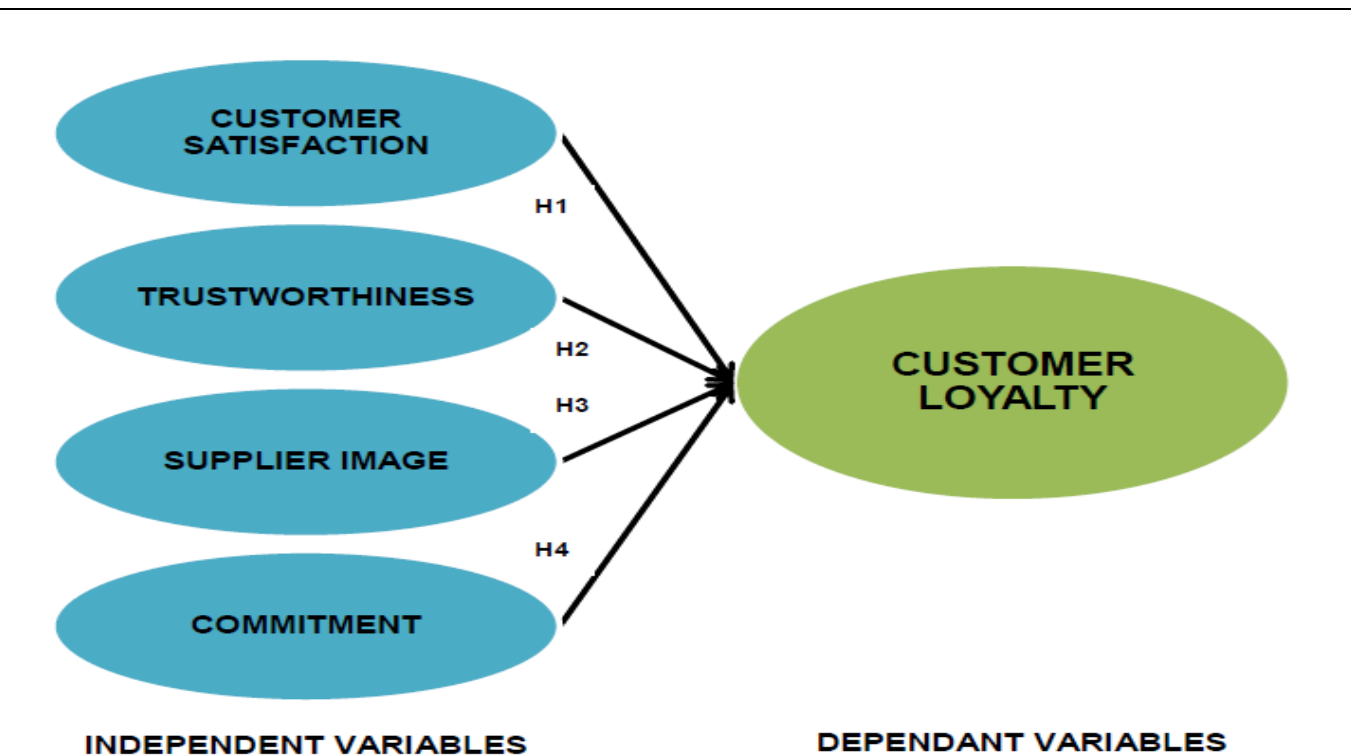
Figure 1.1: Conceptual